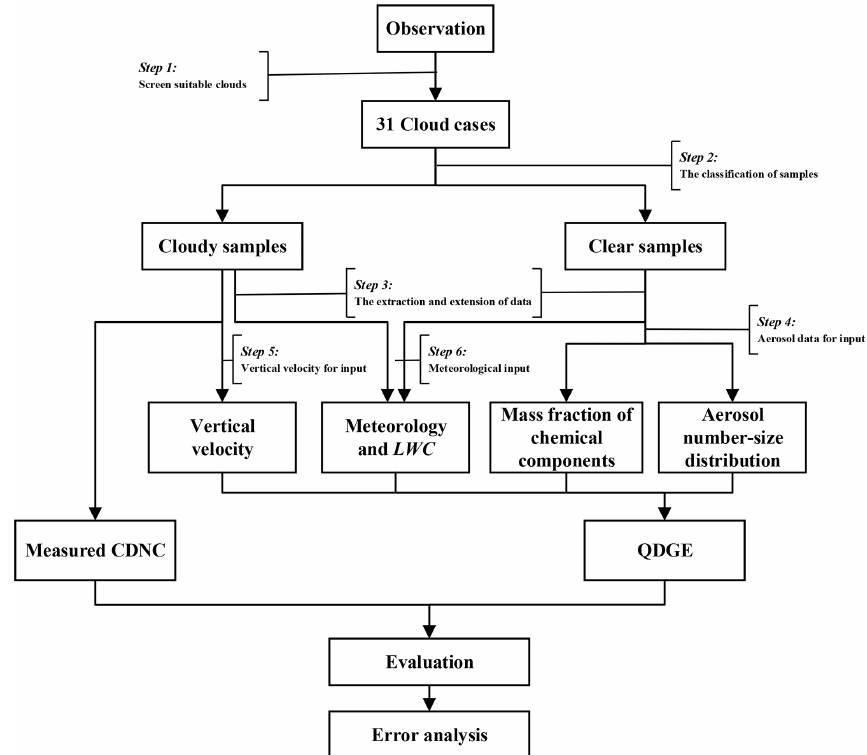
Figure 5. A flow chart to schematically show the data extraction and processing for this work.